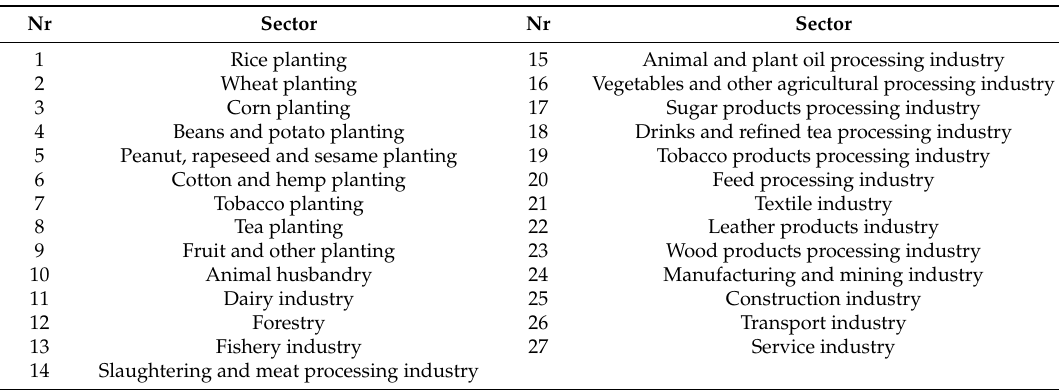
Table 1. Sector definition in this